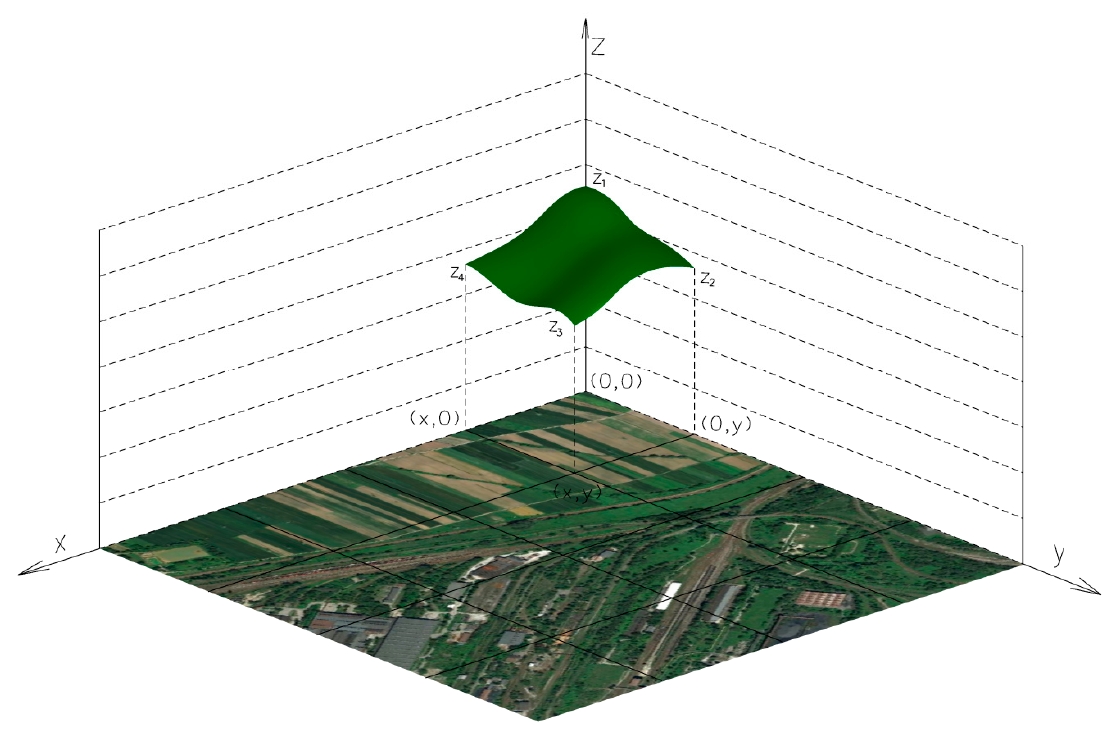
Figure 4. Spatial distribution of a particular factor within the area of a single interpolation network mesh. Source: own research based on [14].